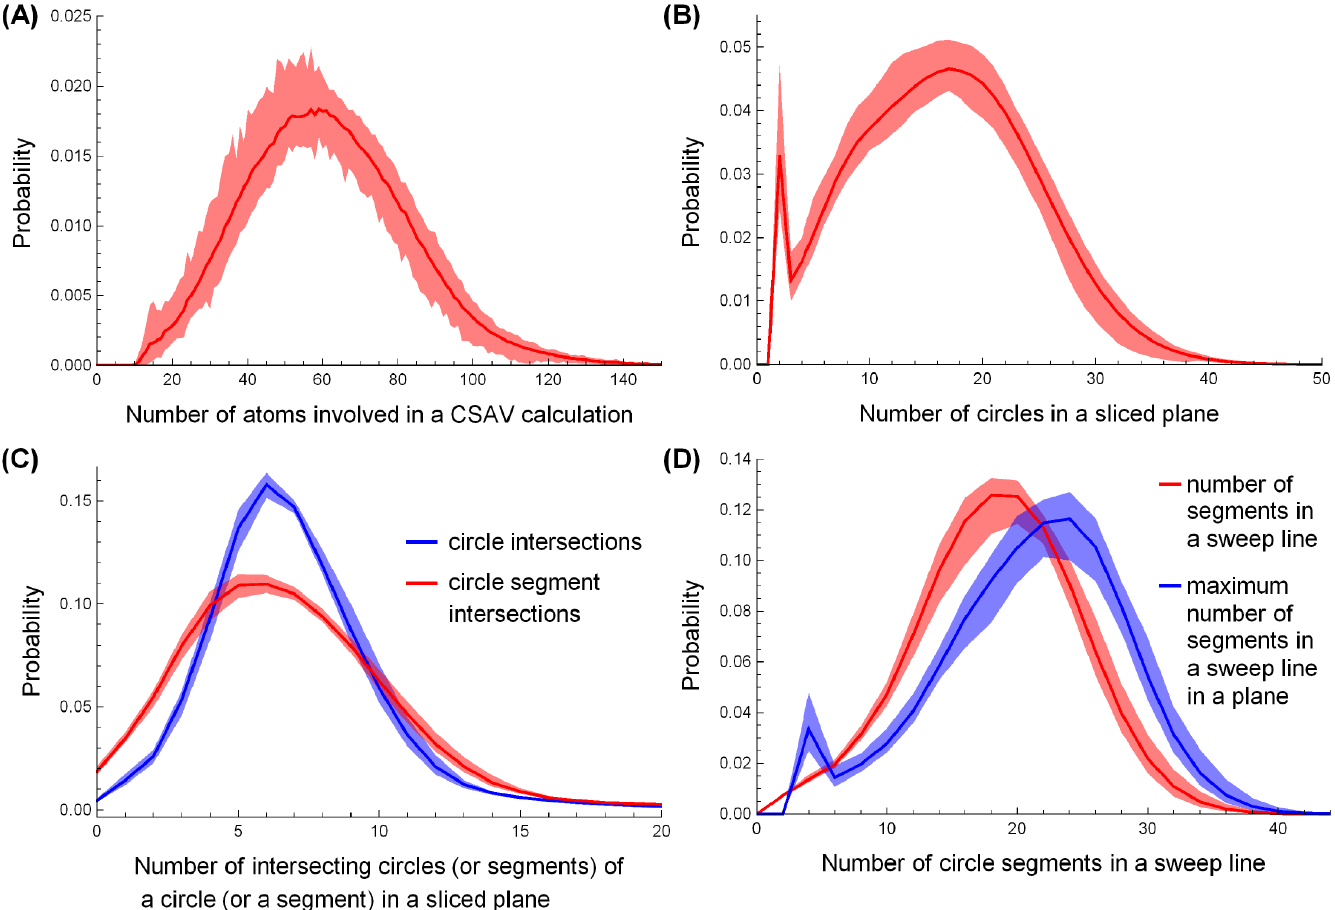
Fig 5. The statistics of the number of atoms, circles, circle segments, and intersections. The probability distribution averaged over the 52 proteins of (A) the number of atoms in a CSAV calculation, (B) the number of circles in a cross-sectional plane, (C) the number of intersections between circles (and circle segments) in a cross- sectional plane in red (and blue), and (D) the number (and the maximum number) of circle segments in a sweep line in red (and blue). The pink and light blue bands represent the range between the 5th and 95th percentiles of the red and blue probabilities determined from the 52 proteins,